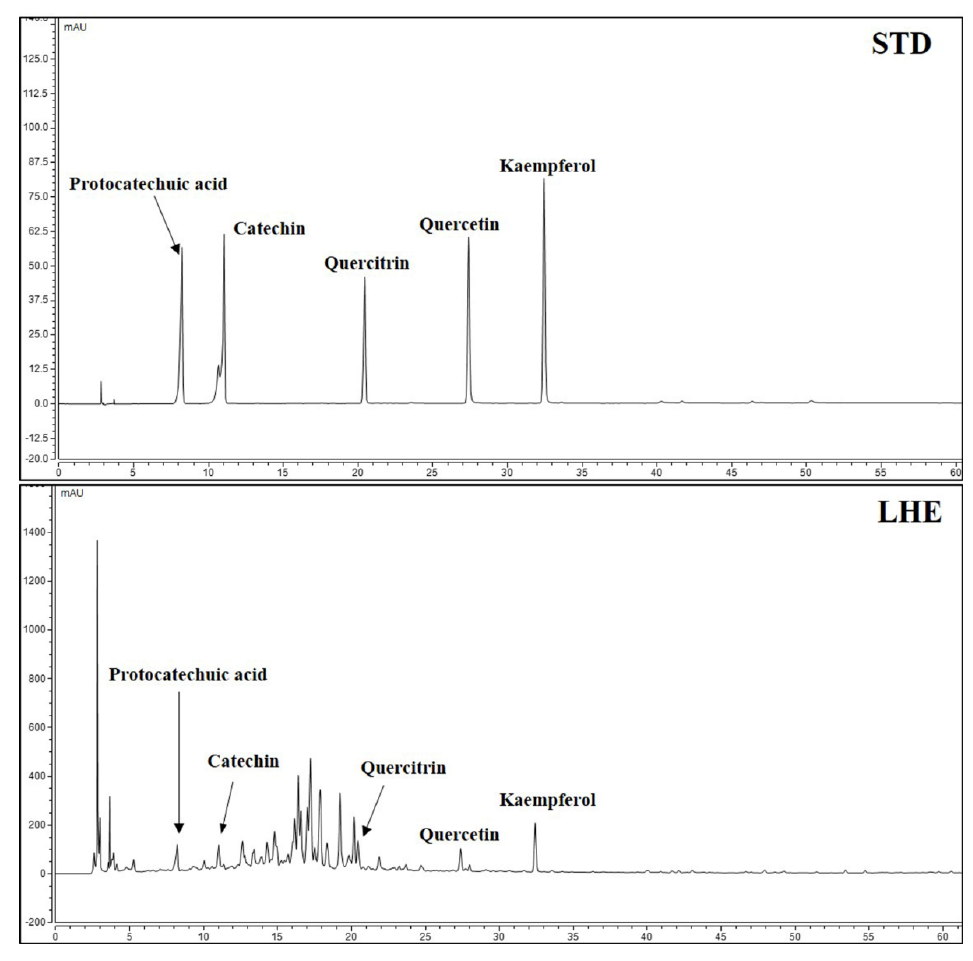
Figure 7. HPLC chromatograms of standard solution and LHE at 270 nm.